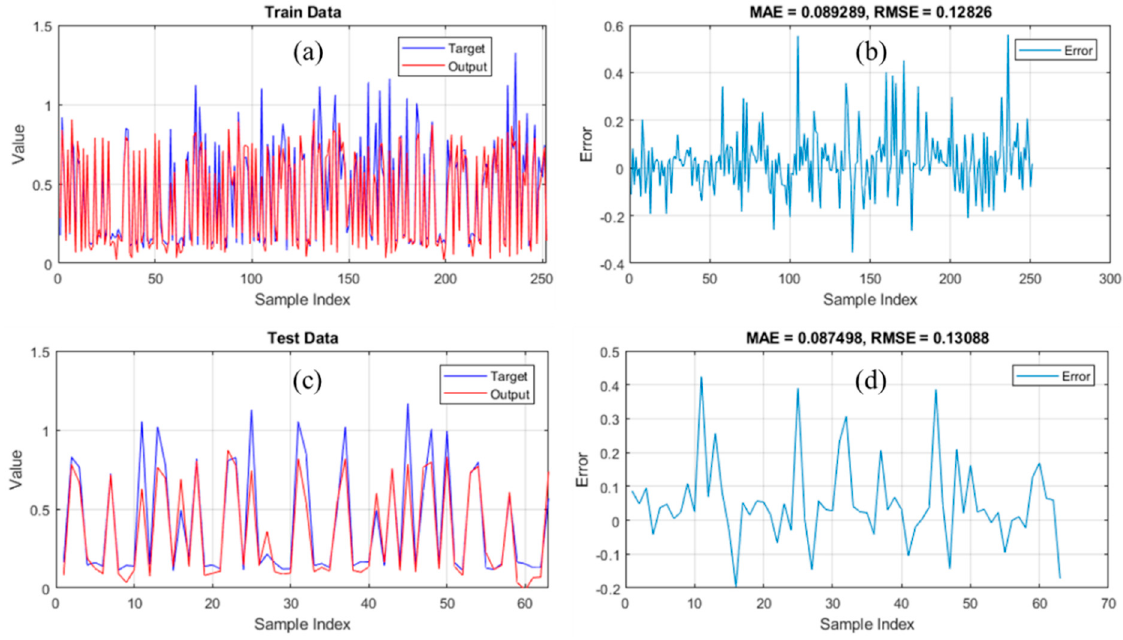
Figure 8. The SHO–ANN results for the ( a , b ) training and ( c , d ) testing data.